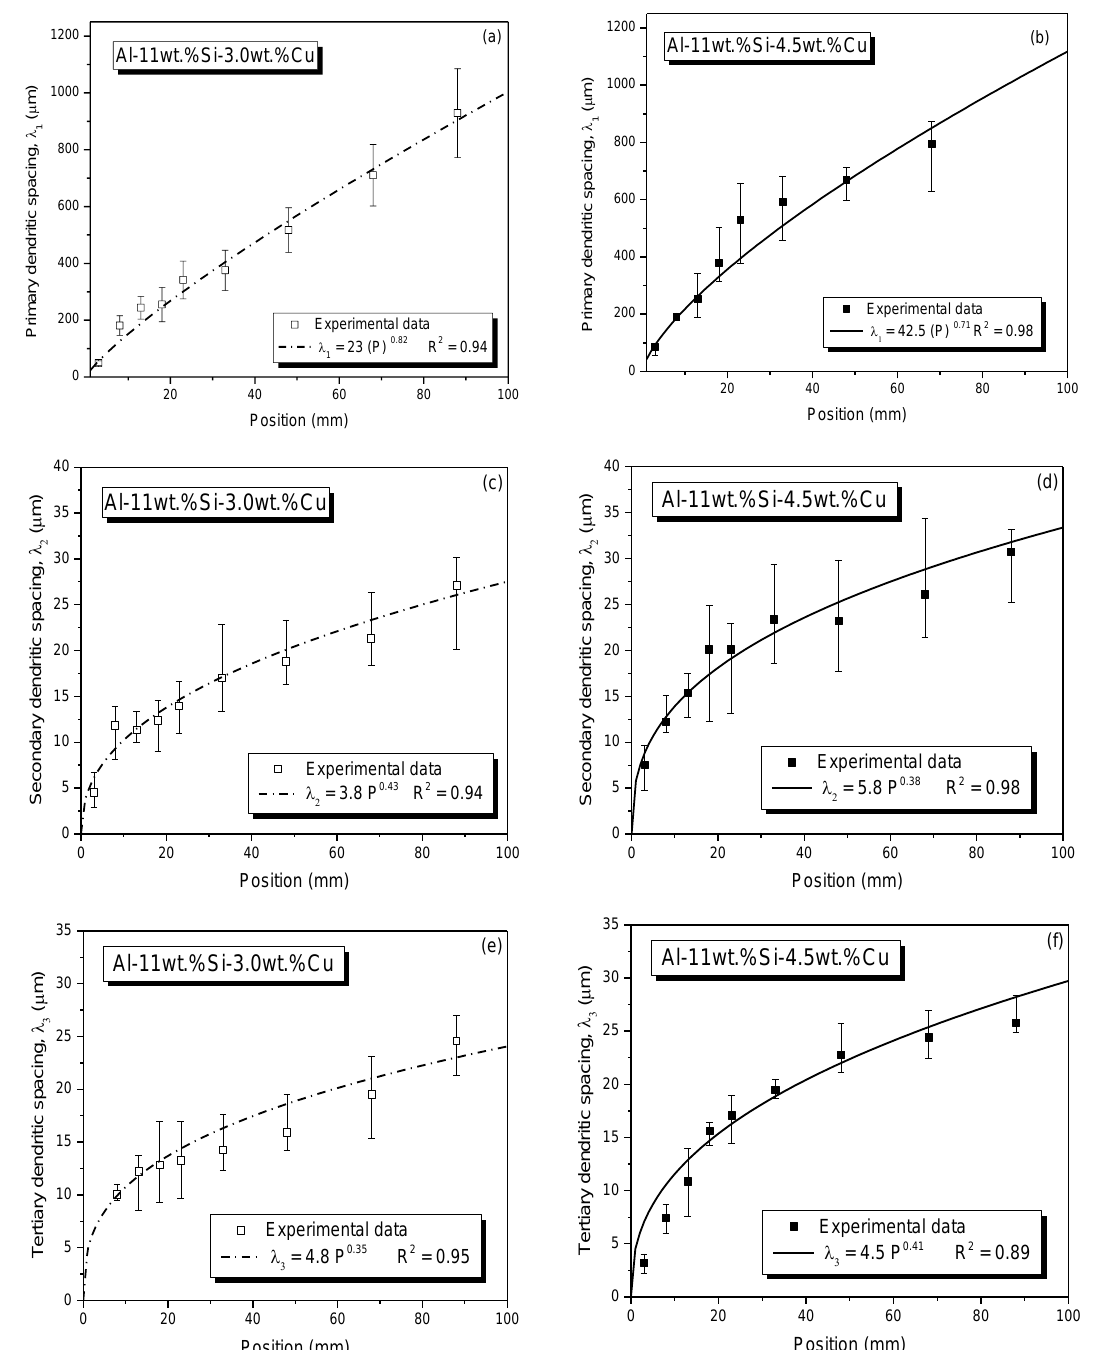
Figure 8. Primary ( a , b ), secondary ( c , d ), and tertiary ( e , f ) dendrite arm spacing variations across the length of the Al-11Si- x Cu braze alloy castings.